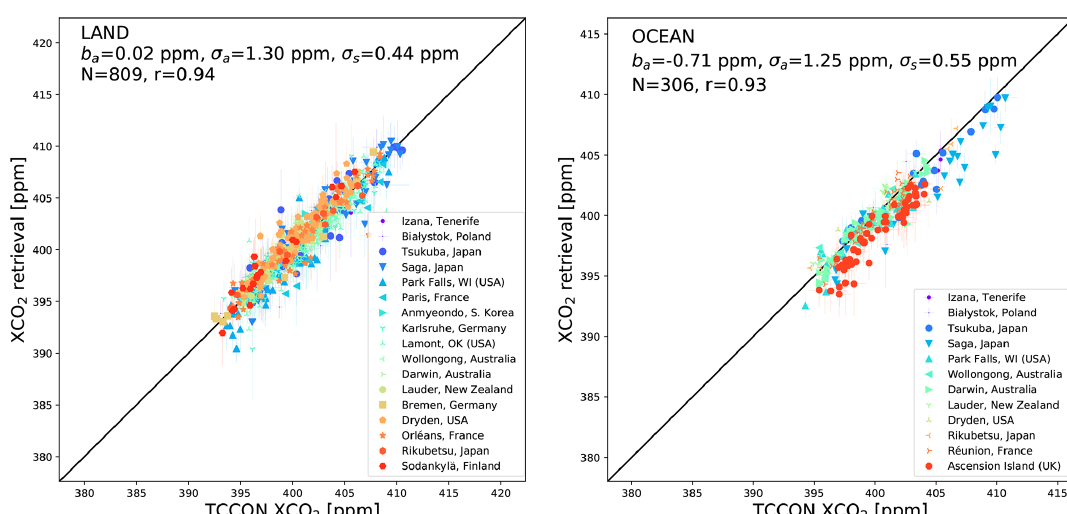
Figure 1. X CO 2 retrievals by using only the 2 . 06µm band of OCO-2. We evaluate overpass-averaged results over land and ocean separately. In each panel, we include bias ( b a ), standard deviation of the difference ( σ a ), station-to-station variability ( σ s ), number of overpasses ( N ), Pearson correlation coefficient ( r ), and one-to-one line. For each overpass, variations in X CO 2 retrievals and TCCON data are presented with error bars.